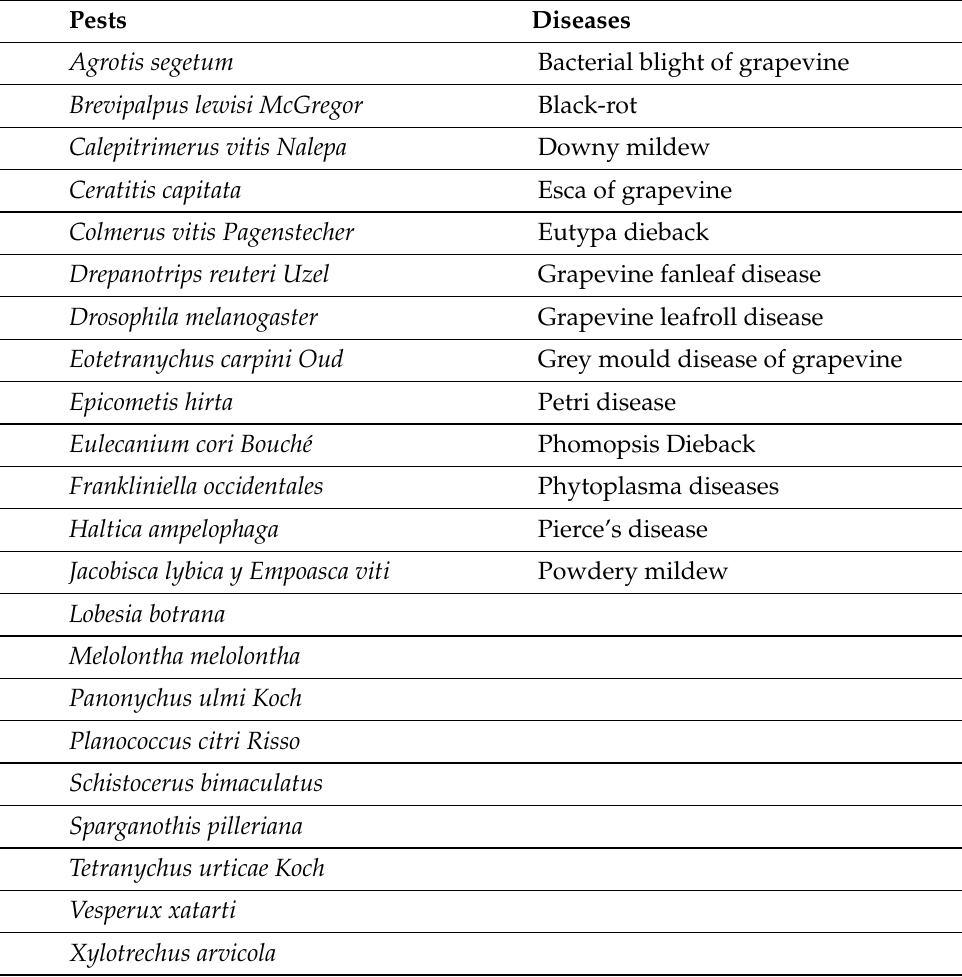
Table 1. List of pests and diseases detected by